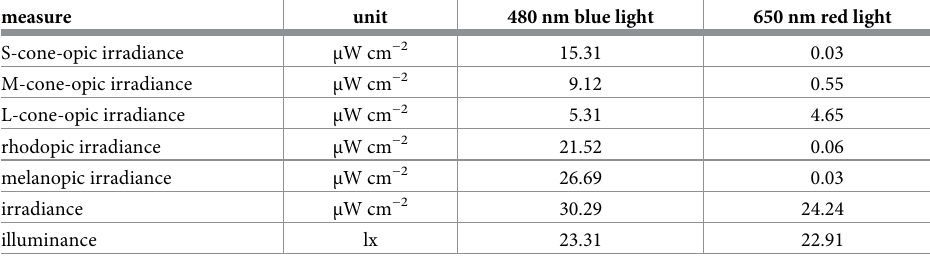
Table 1. Comparison of the two test light conditions in terms of irradiance, photopic illuminance, and α -opic irra- diances of the individual retinal photoreceptors, i.e., S-, M-, L-cones, rods, and ipRGCs.